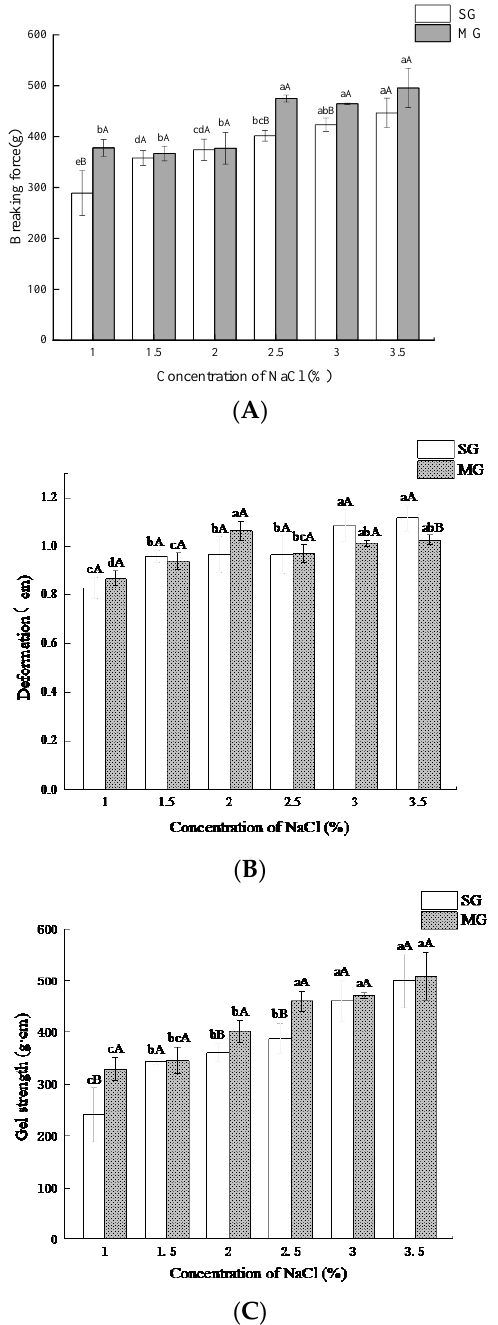
Figure 1. Effects of different NaCl concentrations on breaking force ( A ), deformation ( B ), and gel strength ( C ) of SG (surimi gels) and MG (mixed gels). Different lowercase letters show significant differences between the groups with different NaCl concentrations ( p < 0.05). Different capital letters show significant differences ( p < 0.05) between SG and MG.